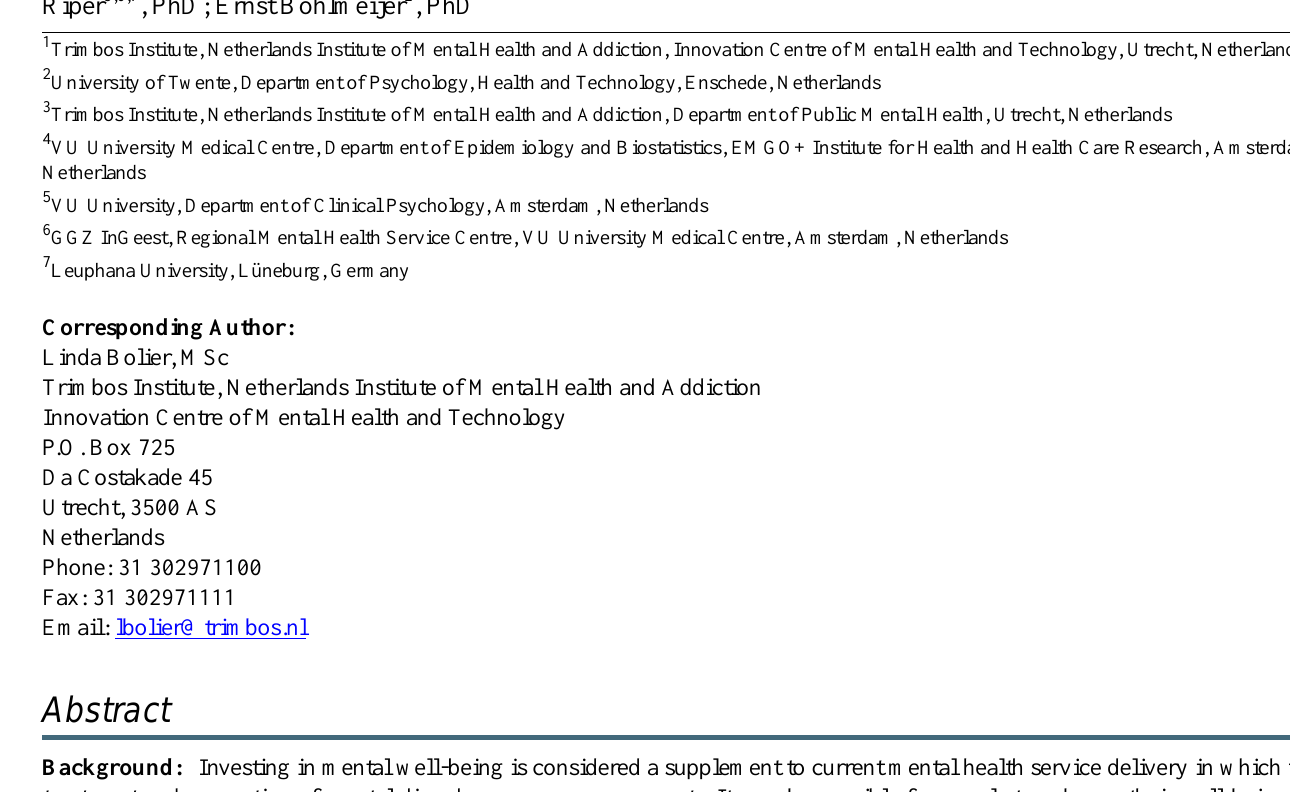
Mental health; public health; preventive medicine; depression, well-being;